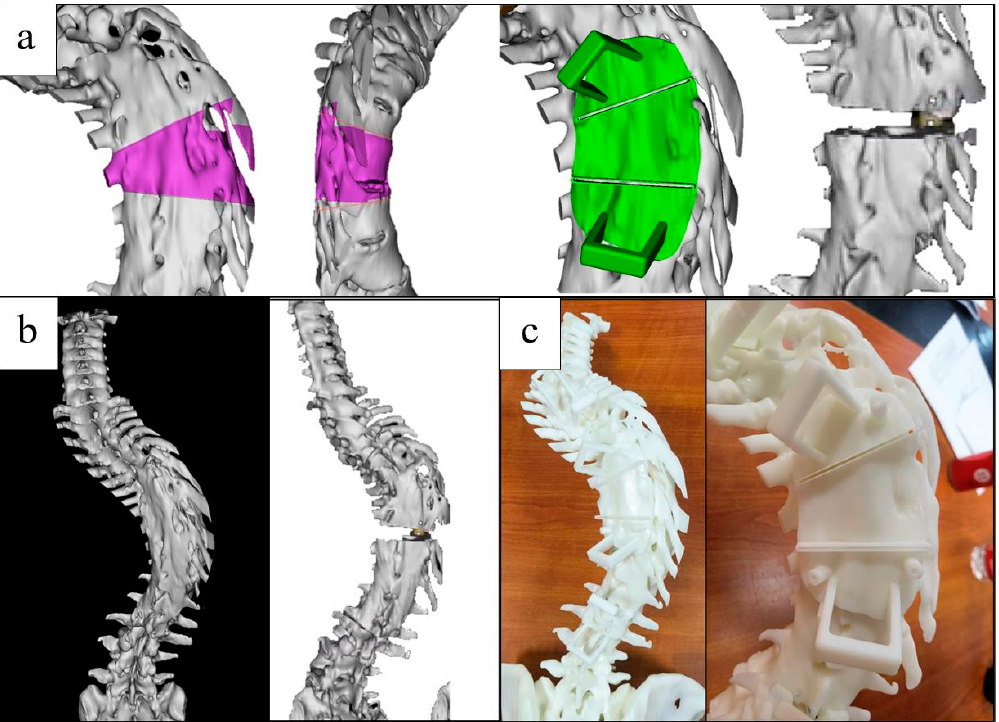
Figure 7. Guidance templates design for case 1 with kyphoscoliosis deformity. ( a ) Design of osteotomy and preview of outcome; ( b ) spine construction in pre- and post- designed operation; ( c ) 3DP spine model and osteotomy guidance template.